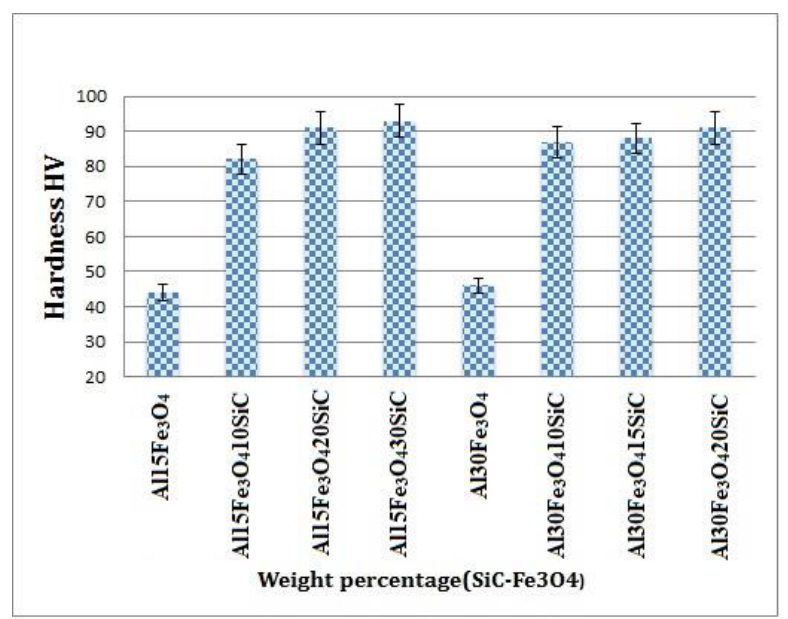
Figure 8. The variation of Vickers hardness value of the as-prepared different composites of Al-Fe 3 O 4 - SiC.